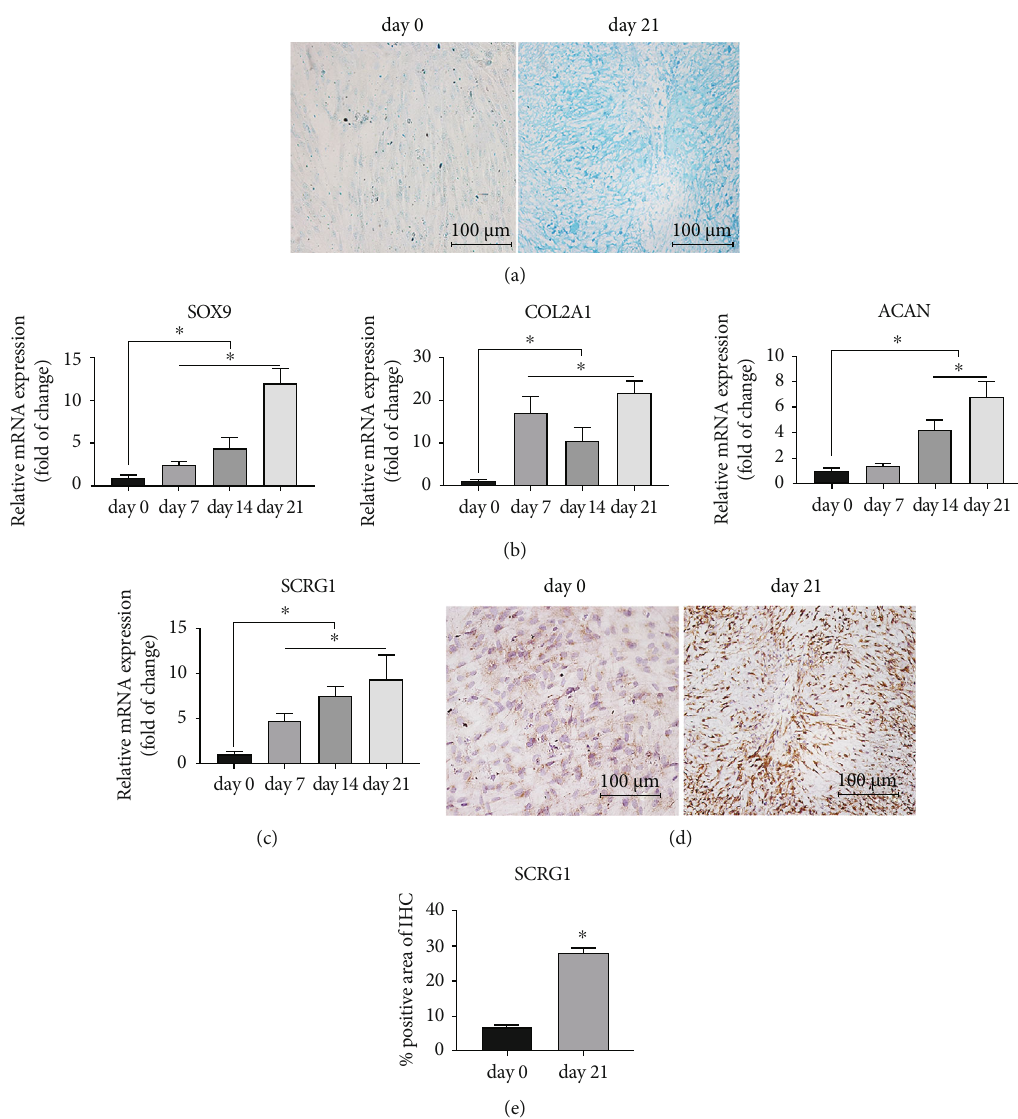
Figure 2: SCRG1 was upregulated during chondrogenic di ff erentiation. (a) Alcian Blue staining of UCMSCs chondrogenic di ff erentiation at day 0 and day 21; results showed accumulation of glycosaminoglycans at day 21 after chondrogenic di ff erentiation, indicating chondrogenesis of UCMSCs. Scale bar = 100 μ m . (b) mRNA expression levels of chondrogenic genes ( SOX9 , COL2A1 , and ACAN ) were upregulated during induction. (c) mRNA expression level of SCRG1 was upregulated during induction. (d, e) Protein level of SCRG1 was upregulated after 21 days chondrogenic di ff erentiation, as detected by IHC. Scale bar = 100 μ m . Experiments were repeated three times; ∗ P < 0 : 05 ( t